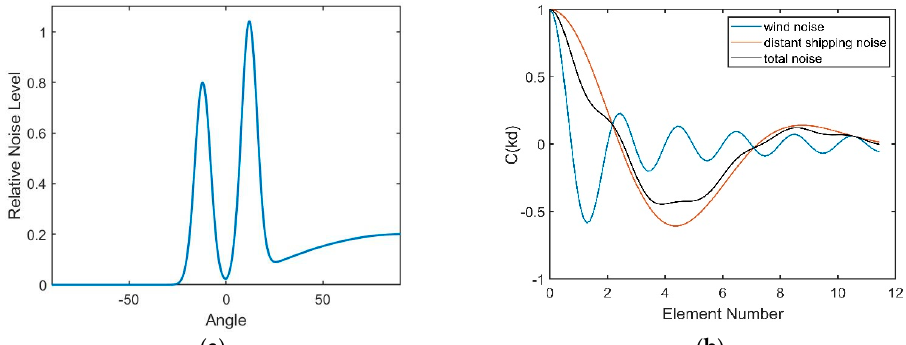
Figure 17. ( a ) Directional density of the total noise at the depth of the DSC; ( b ) Vertical correlation coefficients.